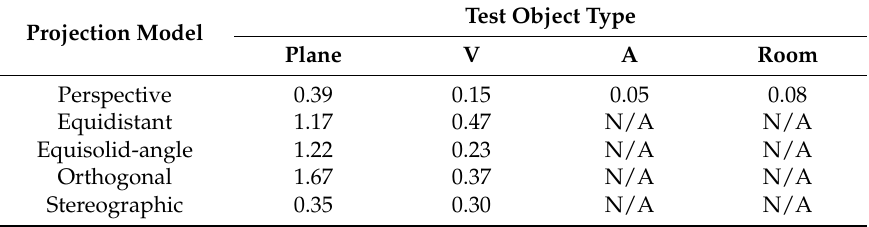
Table 11. RMSE of focal length